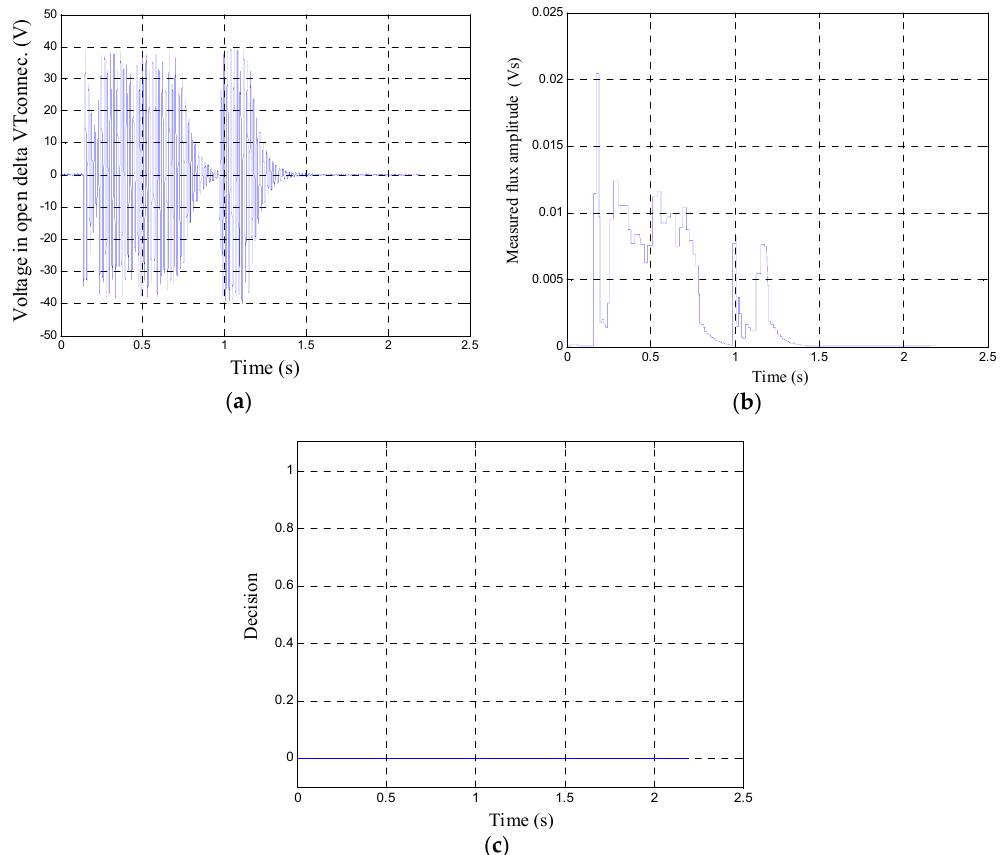
Figure 9. Recorded fault case no.1: ( a ) voltage in open delta VT connection; ( b ) measured flux amplitude; ( c ) proposed algorithm operation.